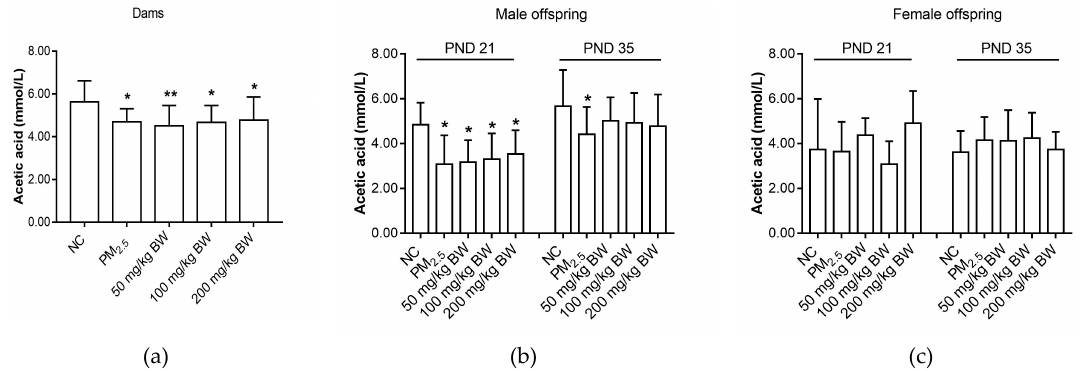
Figure 2. Acetic acid concentrations of dams and offspring. (a) Acetic acid of dams on PND 21. (b) Acetic acid of male offspring on PND 21 and PND 35. (c) Acetic acid of female offspring on PND 21 and PND 35. The data was expressed as mean ± SD of each group. Compared with the NC group, * indicates p < 0.05, ** indicates p < 0.01.